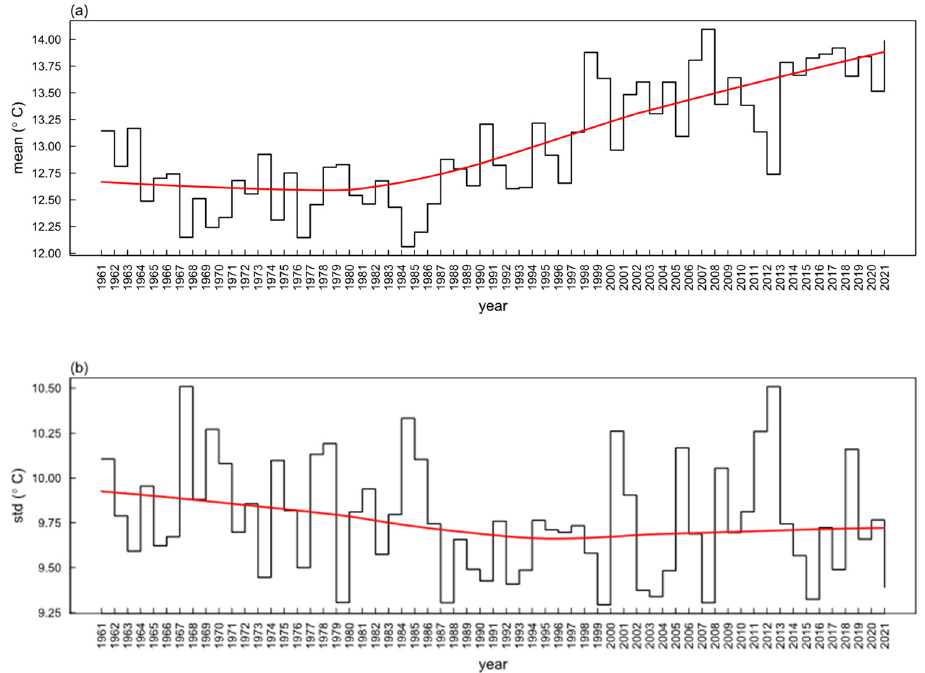
Figure 2. Histogram of the mean and standard deviation of the daily maximum temperature series for all grid points from 1961 to 2021 and its LOWESS trend fitting line. ( a ) Shows the mean of the daily maximum temperature series for all grid points from 1961 to 2021, and ( b ) Shows the standard deviation of the daily maximum temperature series for all grid points from 1961 to 2021.